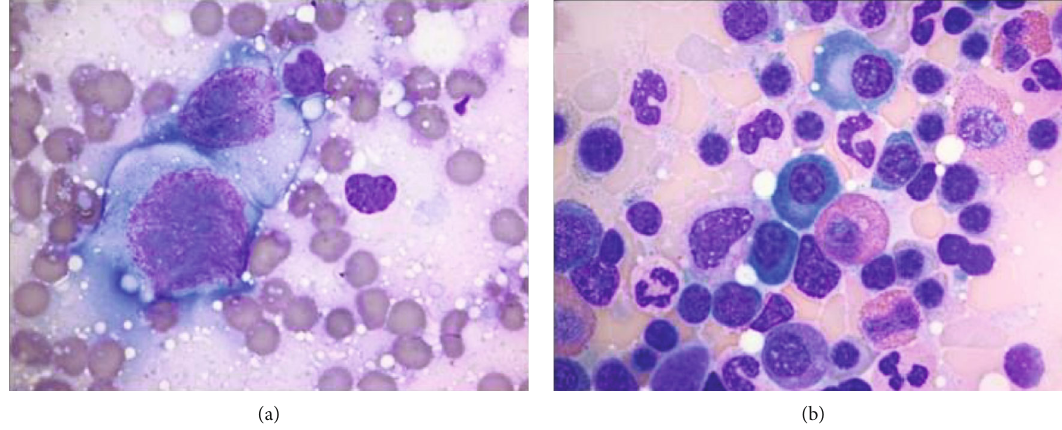
Figure 6: (a) Touch preparations from the PBL maxillary mass showing malignant cytology featuring enlarged nuclei, with high nuclear/cytoplasmic ratios, fi ne open reticular chromatin, and multiple prominent nucleoli (Di ff -Quik stain, 1000x). (b) Aspirate smears from the bone marrow biopsy showing mature plasma cells (Wright-Giemsa,